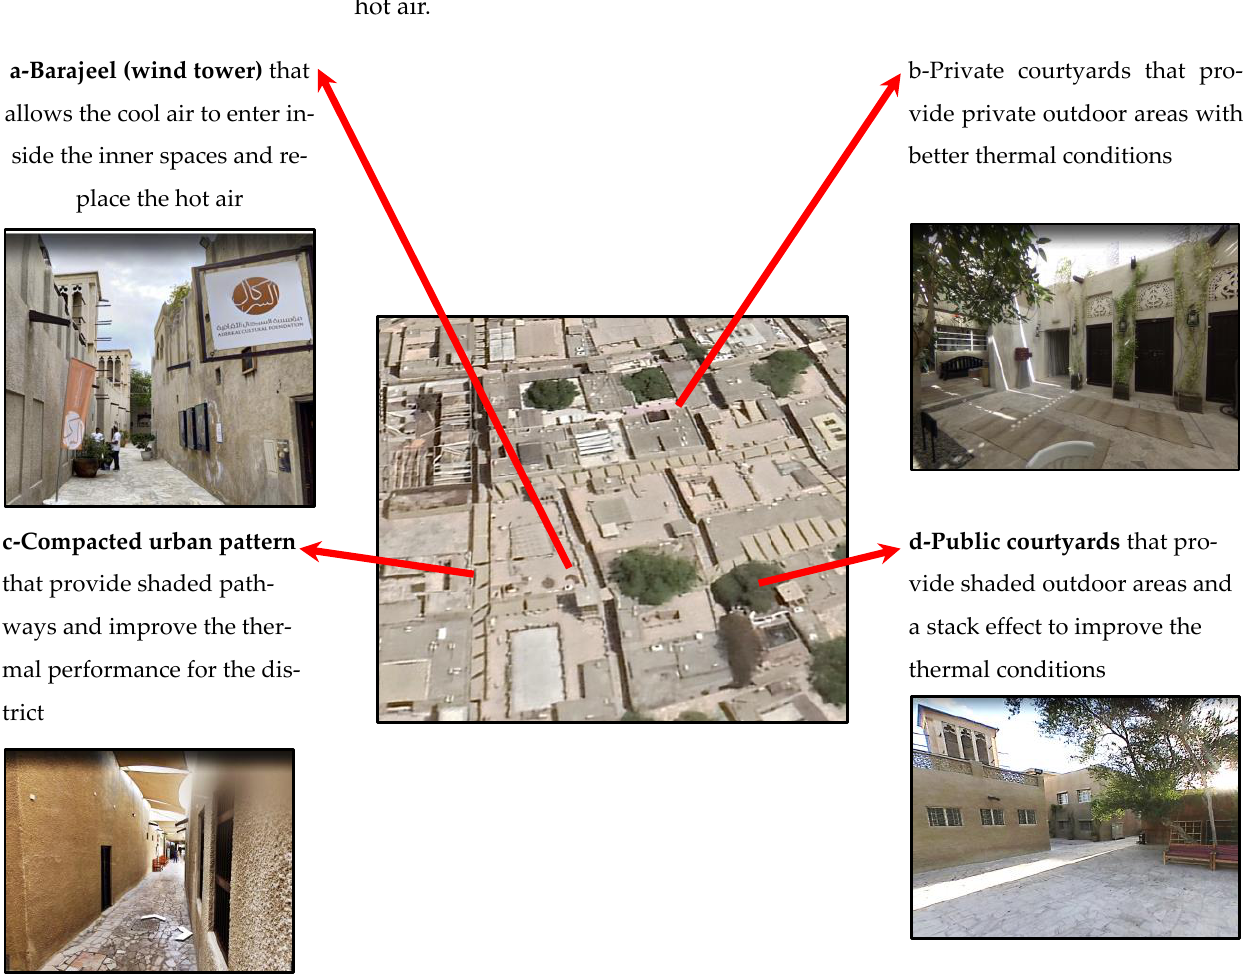
Figure 6. Al Fahidi district — the traditional area in the Dubai Emirate, UAE [55].